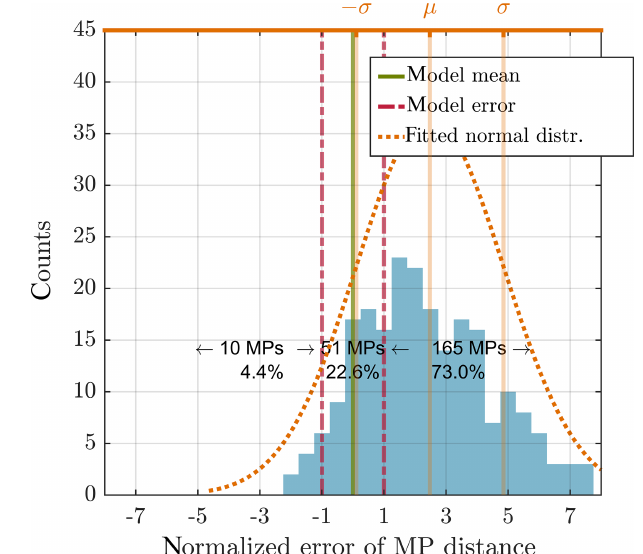
Figure 5. Normalized error of MP distance for outermost crossings. The error range is indicated by the vertical dashed dotted red line. 22 . 6% of MP transitions lay within the model error. The mean is at 2 . 48, the standard deviation is 2 . 37 and the skewness is 0 . 89.